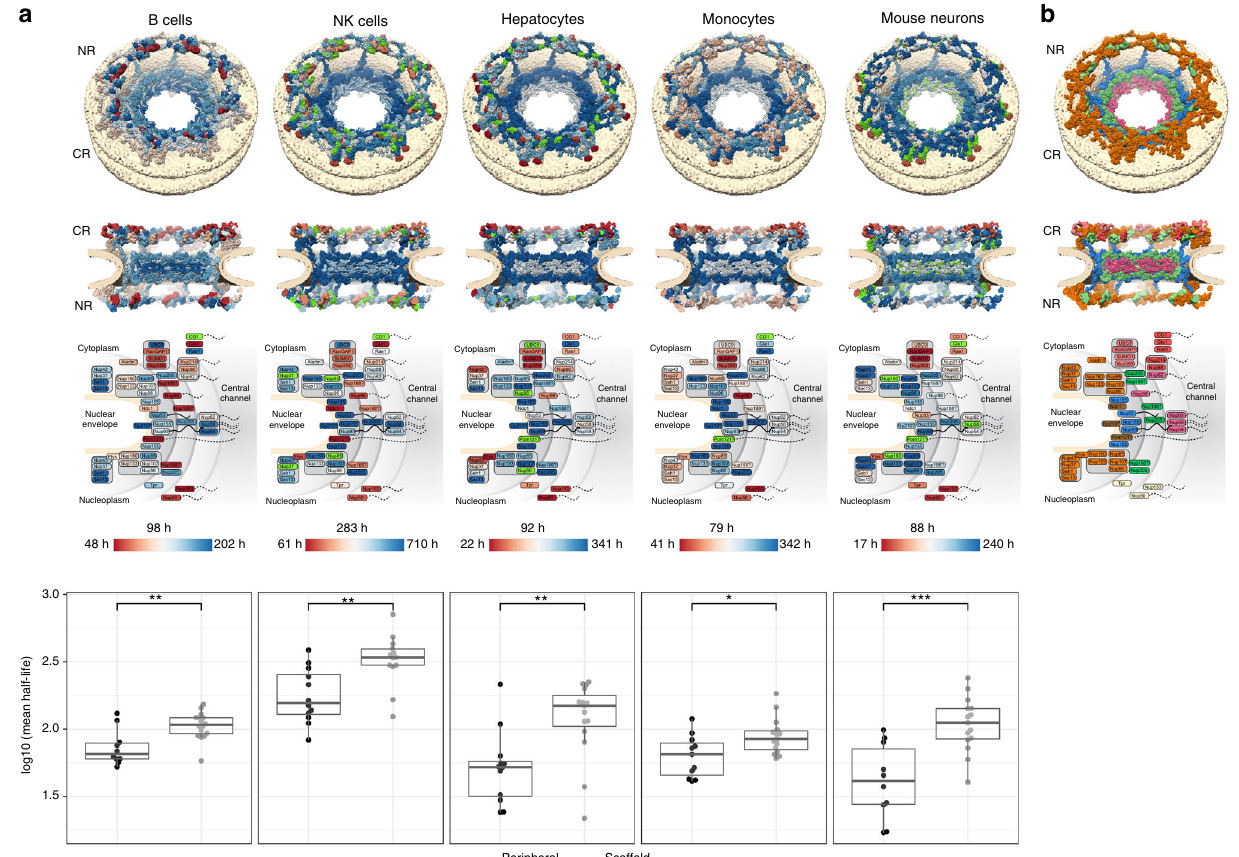
Fig. 5 Architecture-dependent turnover of the nuclear pore subunits. a Upper panel: nucleoporin half-lives mapped onto the structure of the nuclear pore complex. Nups are shown color-coded as gradient from red (short half-life) to blue (long life-life). An architectural model of the nuclear pore 42,43 is shown as seen from top (top panel), cut in half (middle panel), and a subcomplex scheme (bottom panel). The nucleoplasmic side is at the bottom in all cases. For each cell type, half-lives were averaged over two biological replicates, except for rare cases where only one half-life value was available, and converted to a color gradient as explained in the Methods. The median and minimum and maximum half-lives are indicated together with the color bars. Nups with non- determined half-lives are colored green. Lower panel: distributions of the reproducibly measured half-lives of the scaffold and peripheral subunits of the nuclear pore in the different cell types. Differences in the distributions of log 10 half-lives were assessed by Wilcoxon-rank test (signi fi cance levels were encoded as *** p < 0.001, ** p < 0.01, * p < 0.05). Center line in box plots is the median, the bounds of the boxes are the 75 and 25% percentiles i.e., the interquartile range (IQR), and the whiskers correspond to the highest or lowest respective value or if the lowest or highest value is an outlier (greater than 1.5 * IQR from the bounds of the boxes) it is exactly 1.5 * IQR b The same as upper panel in (a) , but color-coded according to Nup subcomplexes. Nups of the inner ring are colored blue, of the outer (Y-complex) rings — orange, trans-membrane nucleoporins — brown, Nup205 and Nup188 — green, nuclear basket nucleoporins — yellow, Nup62 subcomplex — magenta, Nup358 subcomplex — salmon, and Nup214 complex —